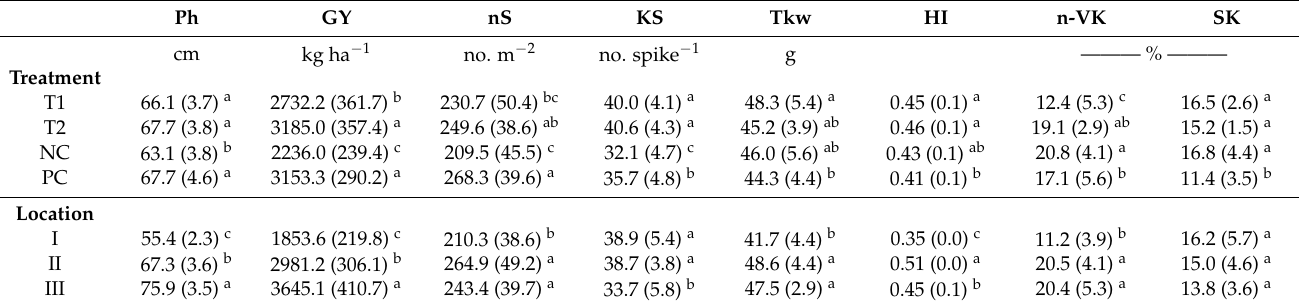
Table 2. The effect of treatment and location on durum wheat plant height (Ph), grain yield (GY), number of spikes (nS), number of kernels (KS), thousand kernel weight (Tkw), harvest index (HI), non-vitreous kernels (n-VK), and skimpy kernels